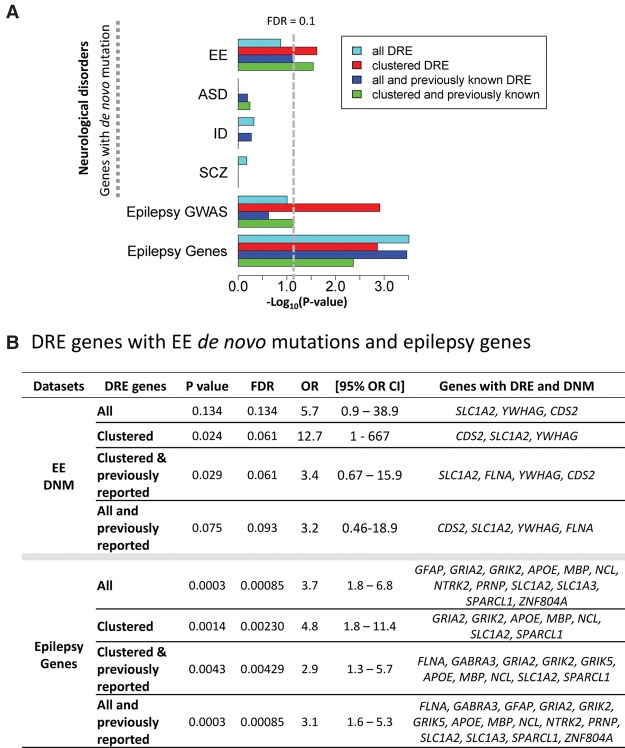
(A) For genes impacted by differential RNA editing, enrichment for de novo mutations from patients with epileptic encephalopathy (EE), autism spectrum disorder (ASD), intellectual disability (ID), and schizophrenia (SCZ); enrichment of association to genetic generalized epilepsy (“Epilepsy GWAS”) and enrichment for known epilepsy genes (Epilepsy Genes) (as defined by DisGeNET). (B) Table summarizes the enrichment P-value, odds ratio (OR), and 95th percentile of the confidence interval of the OR and lists the genes contributing to the enrichment of EE de novo mutations (top) and known epilepsy genes (bottom) among genes differentially RNA-edited in epilepsy.